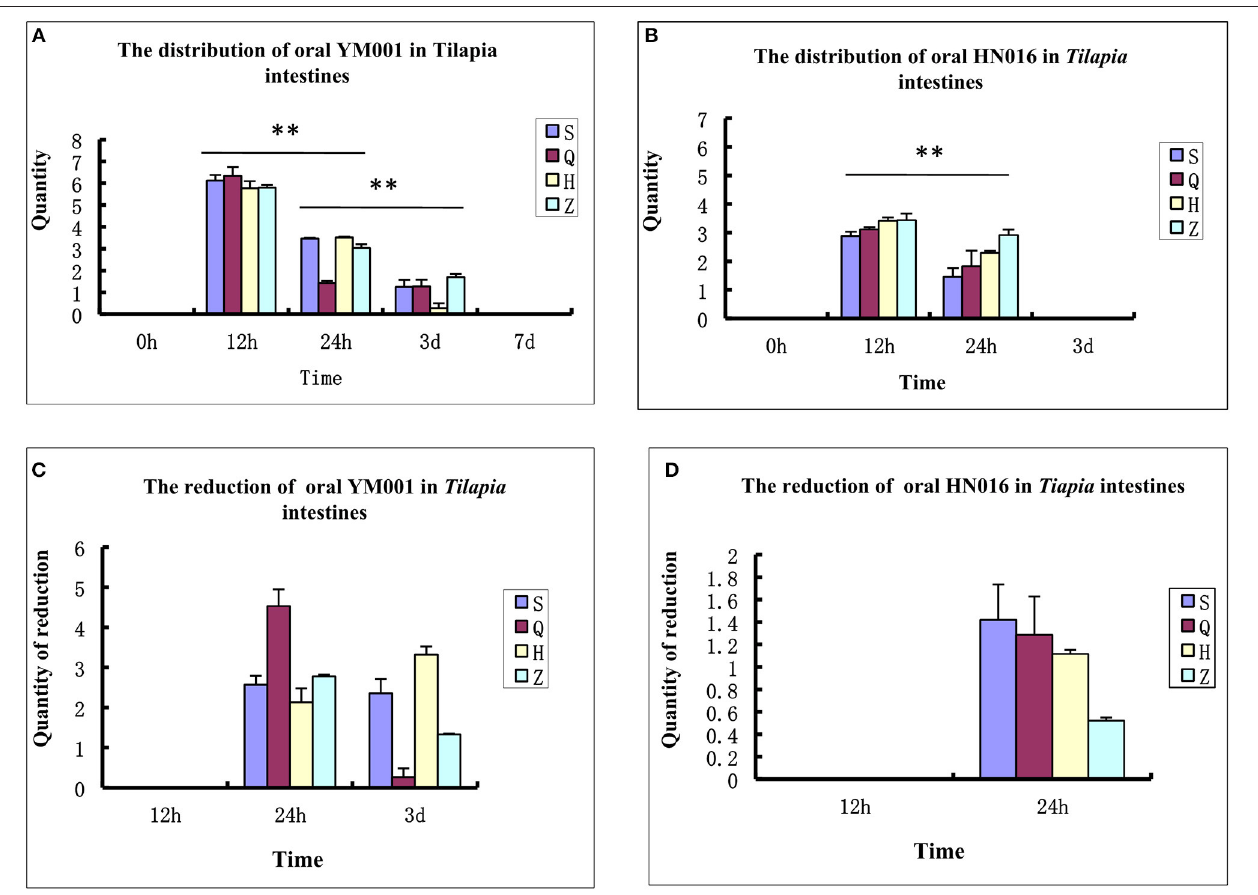
FIGURE 1 | The retention time of YM001 and HN016 is different in the intestinal tract. (A) The distribution of YM001 in Tilapia intestines. (B) The distribution of HN016 in Tilapia intestines. (C) The reduction of YM001 in Tilapia intestines. (D) The reduction of HN016 in Tilapia intestines. Real-time RT-PCR was performed in triplicate for each sample. The data were provided as the mean fold changes (means ± S.D., n = 3) relative to the control group. The statistical significance was calculated by the Student’s t -test (** p <